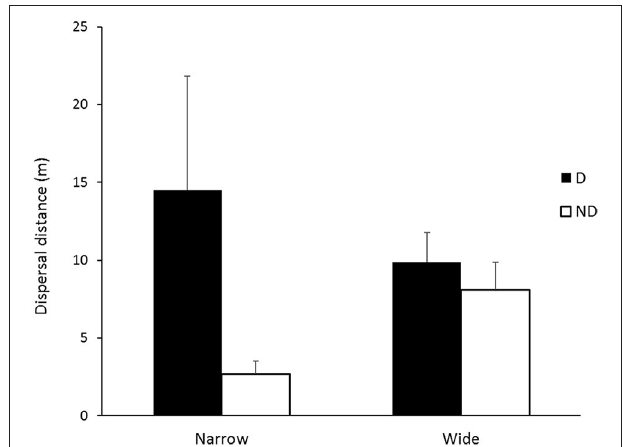
FIGURE 1 | Mean dispersal distances (m) carried out by seed-dispersing ant species in disturbed (D) and non-disturbed (ND) zones in narrow ( n = 579 in D, n = 376 in ND) and wide roadsides ( n = 442 in D, n = 553 in ND) in the Lockhart Shire, southern NSW. Error bars represent standard error of the